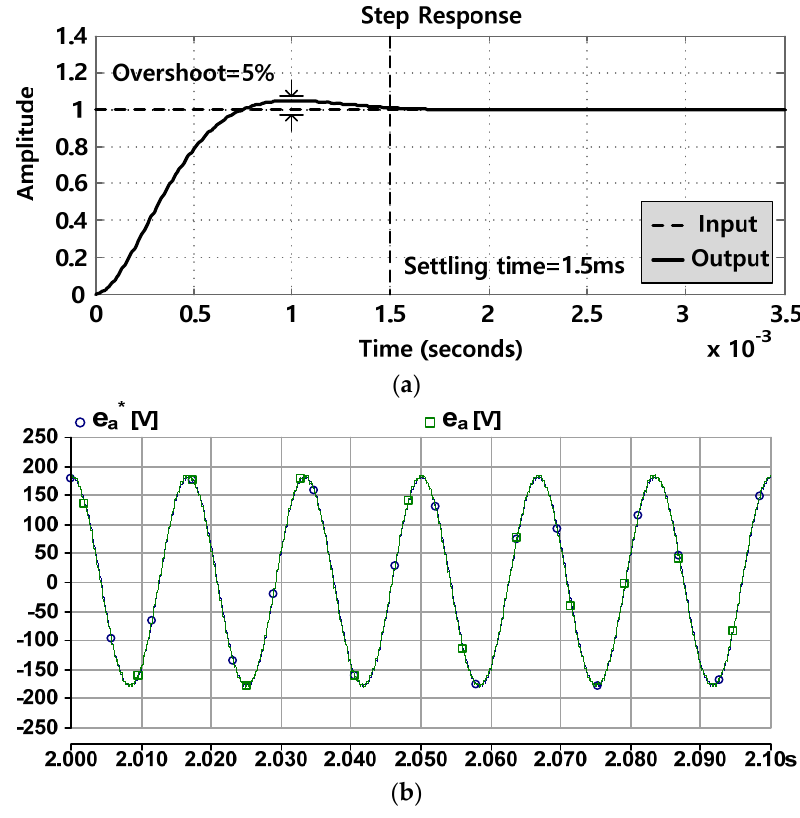
Figure 12. Performance analysis of voltage control: ( a ) Step response; ( b ) Voltage control.